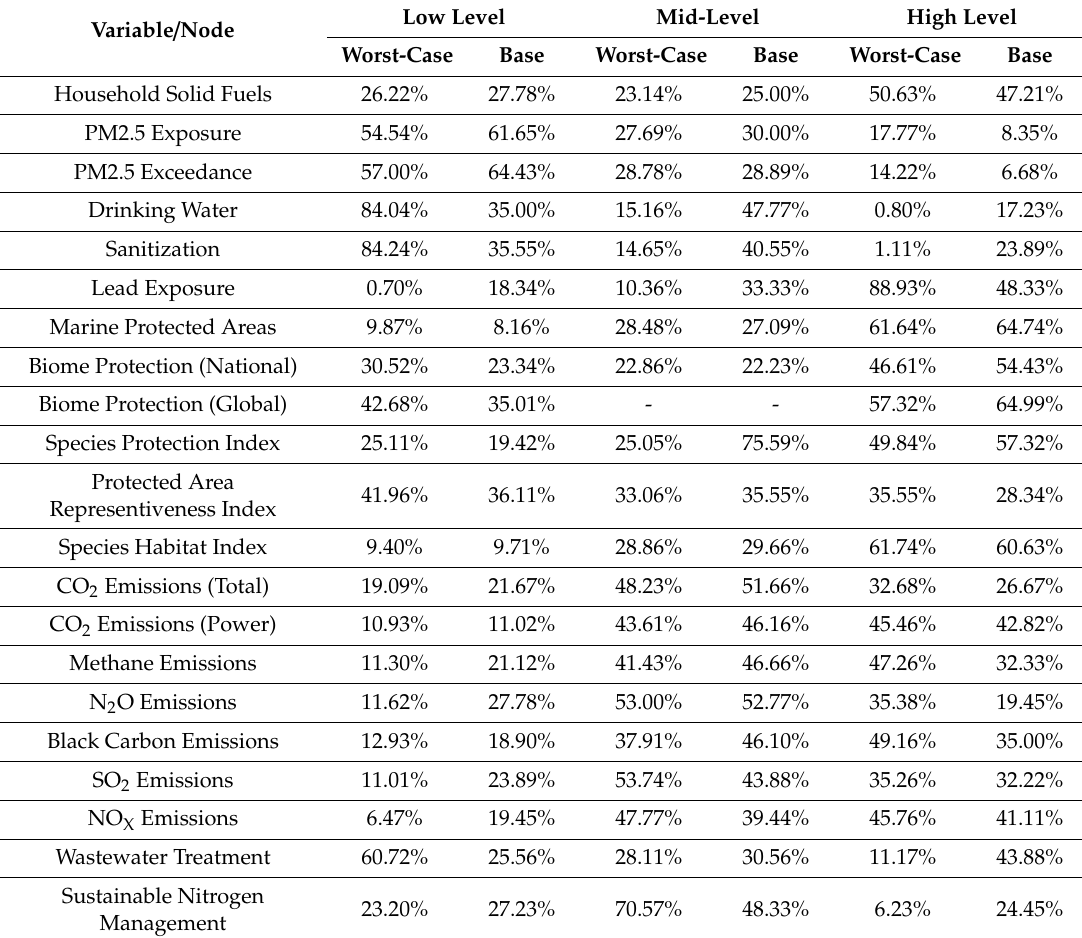
Table 4. Results of predictive analysis of the worst-case